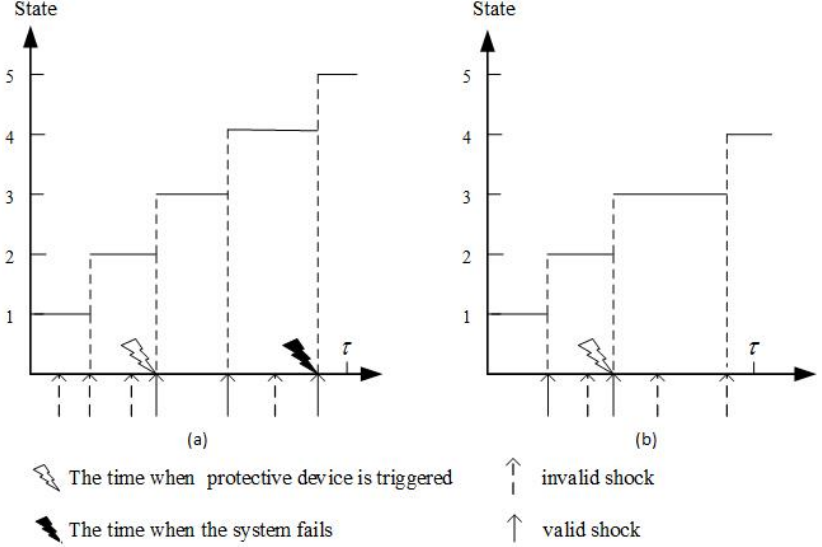
Figure 1. Two possible realizations of the system state evolution processes. ( a ) self-exciting mecha- nism triggered after two consecutive invalid shocks; ( b ) self-exciting mechanism triggered after two valid shocks.